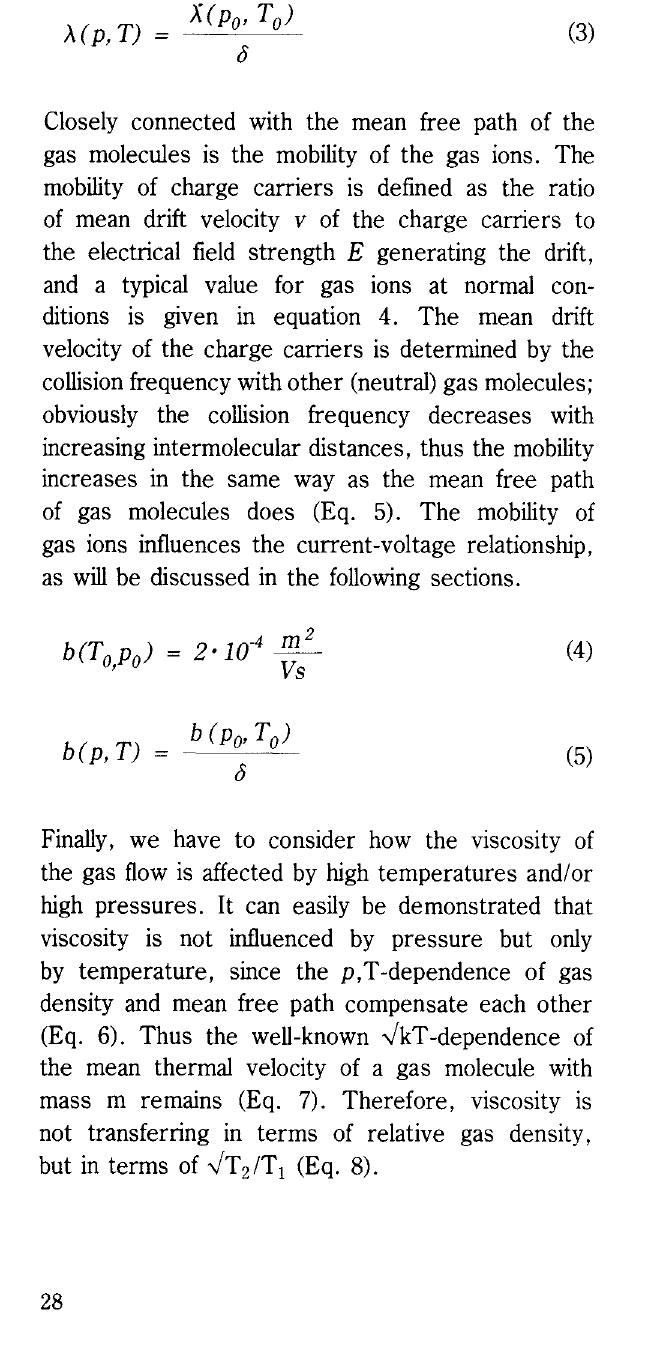
Fig. 1 Relative gas density as a function of temperature; isolines represent constant pressures,